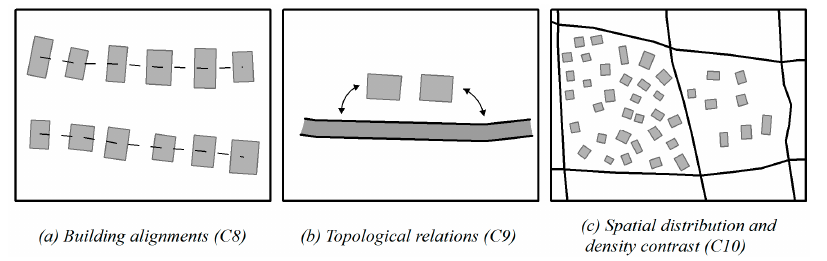
Figure 2. Contextual constraints acting on buildings.